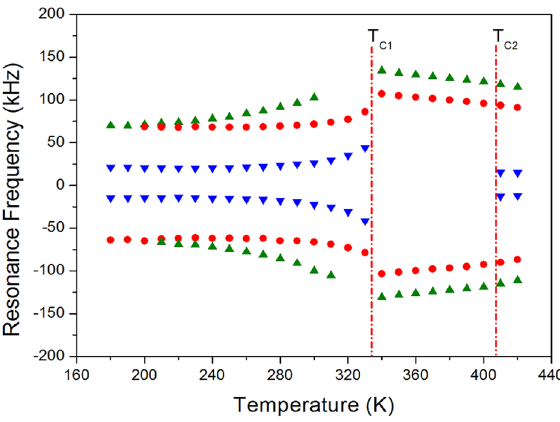
Figure 7. Static 14 N NMR spectra of [NH 3 (CH 2 ) 5 NH 3 ]CdCl 4 at phases I, II, and